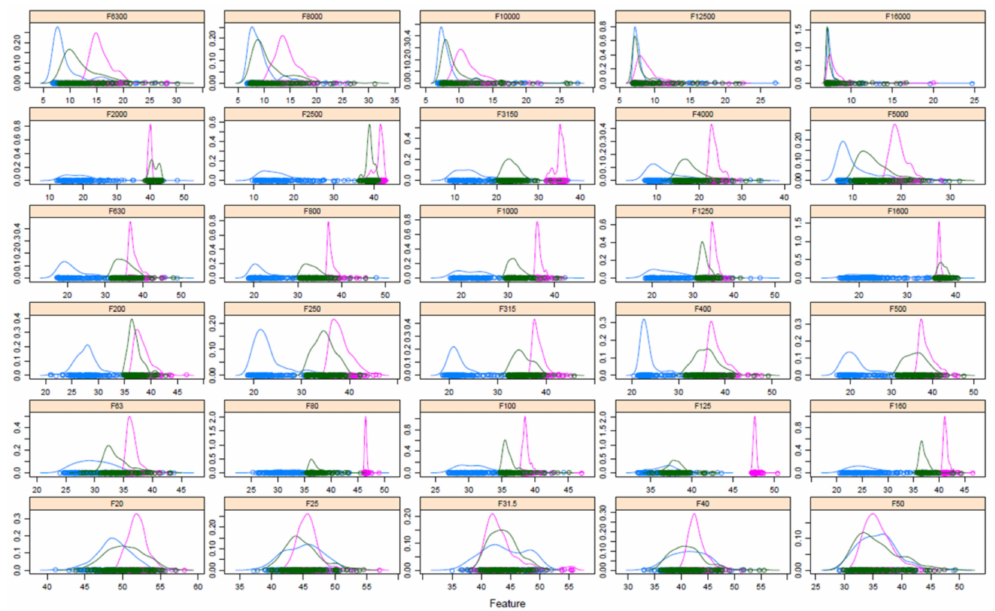
Figure 5. Density lattice plots of the average spectral levels in an 1/3 octave